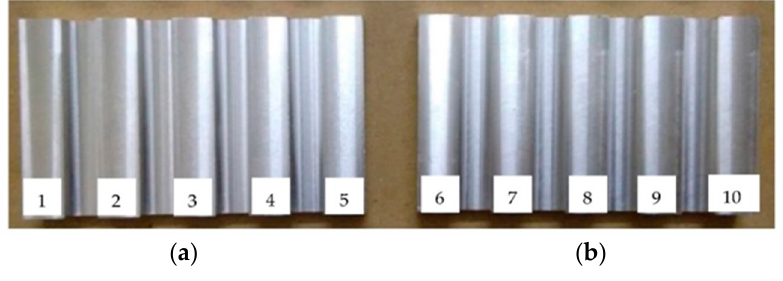
Figure 1. ( a ) Sample 1 and ( b ) Sample 2 with numbering [10].